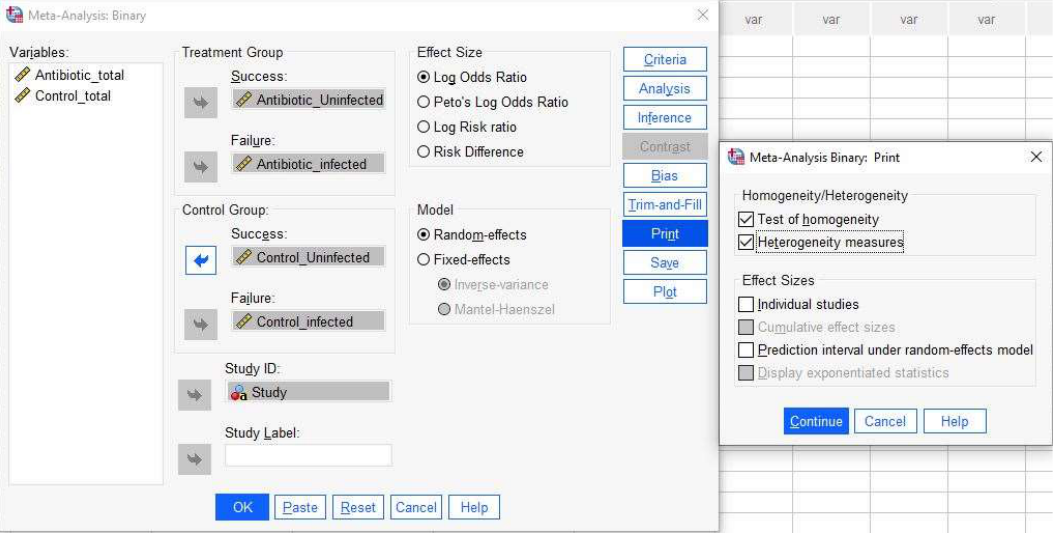
Figure 9. Data identification menu.